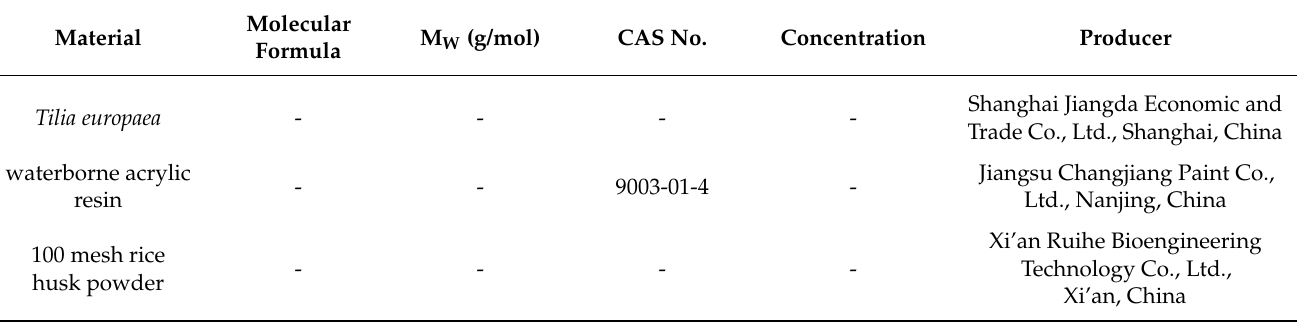
Table 1. List of experimental